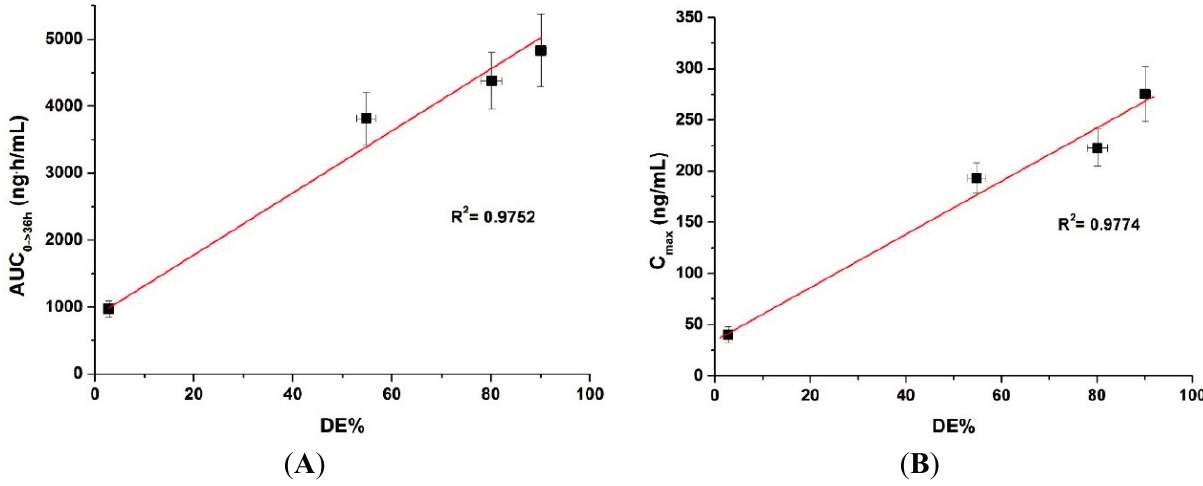
Figure 6. Correlation between the in vitro dissolution efficiency and in vivo pharmacokinetic parameters. ( A ) AUC and ( B ) C max